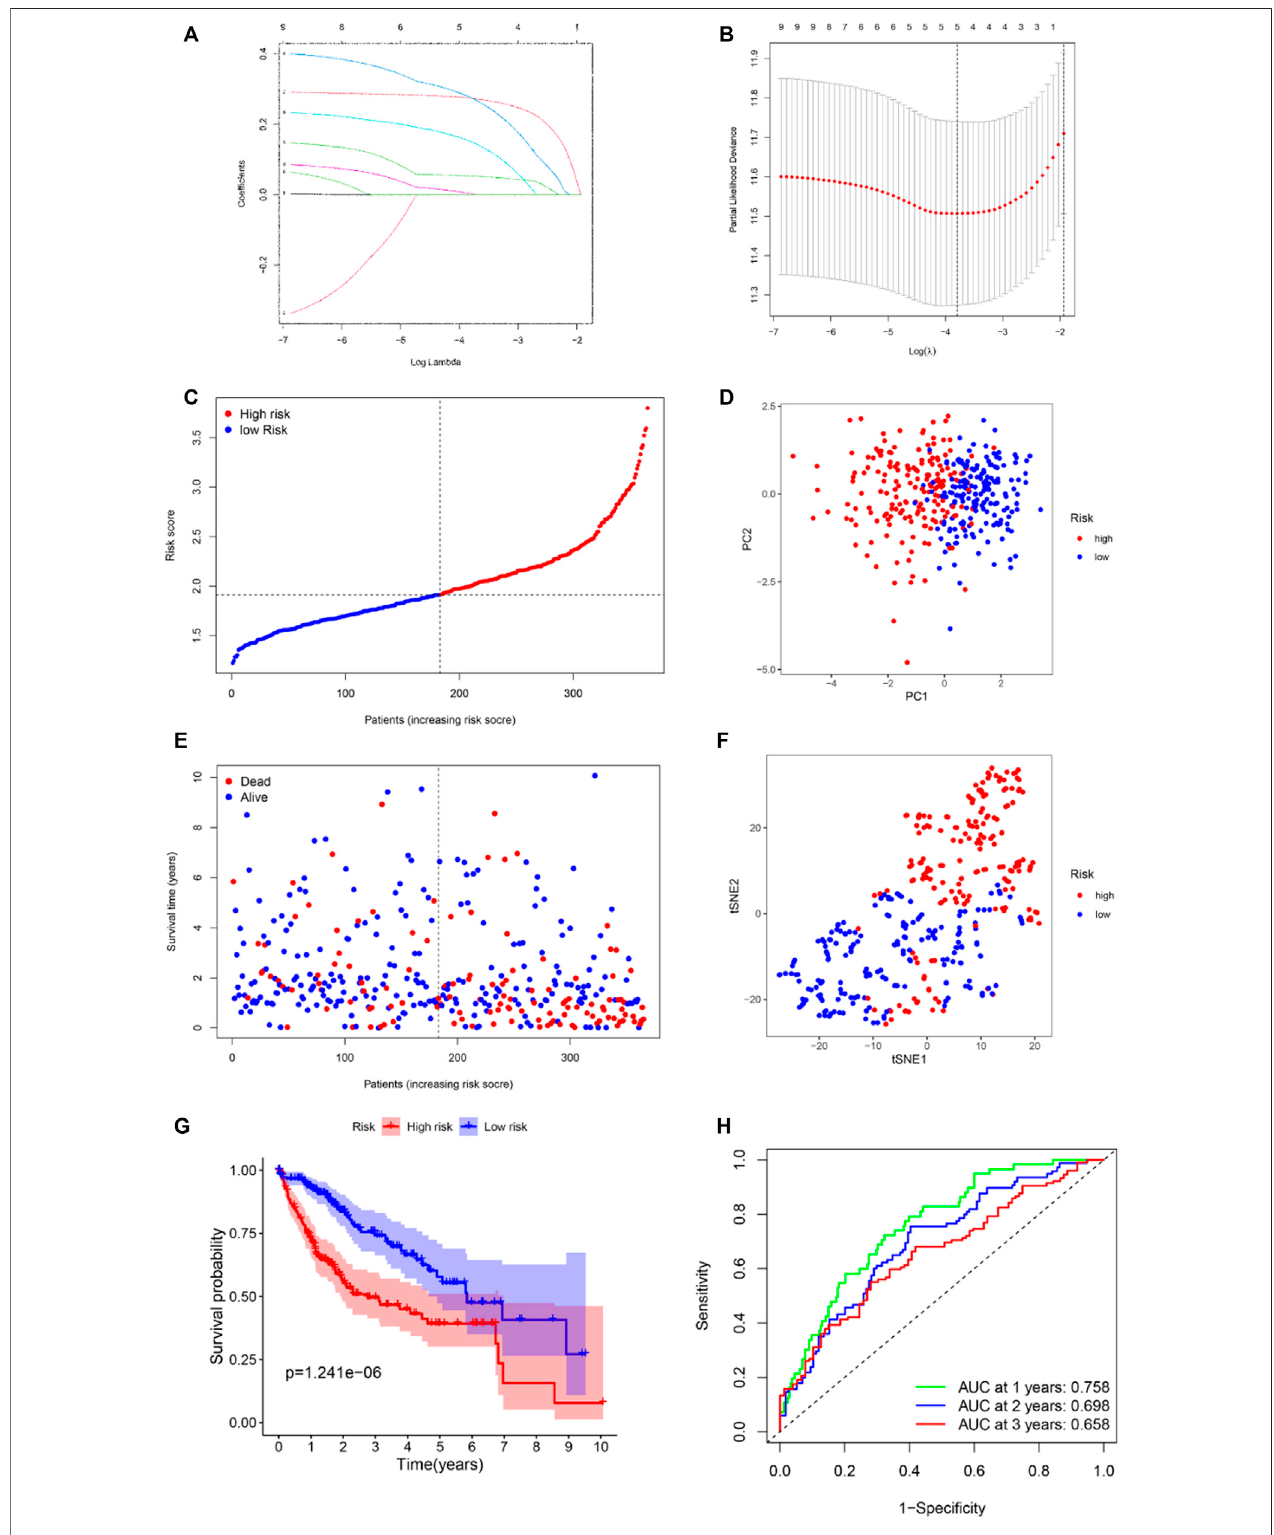
FIGURE 3 | Establishment of ferroptosis-related hub gene signature in the TCGA set. (A) LASSO coef fi cient pro fi les of the expression of 41 candidate genes. (B) Selection of the penalty parameter ( λ ) in the LASSO model via 10-fold cross-validation. An optimal log λ value is indicated by the vertical black line in the plot. Risk score distribution (C) , PCA plot (D) , overall survival (OS) status (E) , and t-SNE (F) analysis of TCGA cohort. (G) Kaplan – Meier curves for comparison of the OS between low- and high-risk groups. (H) Receiver operating characteristic (ROC) curves veri fi ed the prognostic performance of the risk score.